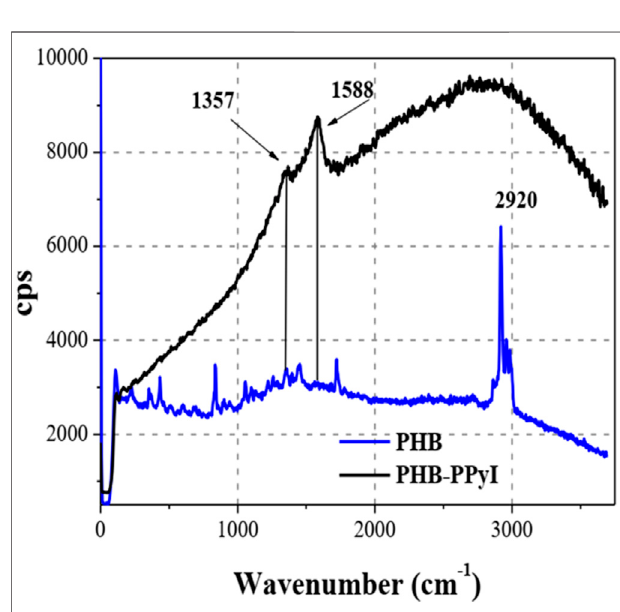
FIGURE 3 | Raman spectra of PHB and PHB-PPyI scaffolds. The broad signal in the PPyI spectrum is due to fl uorescence.